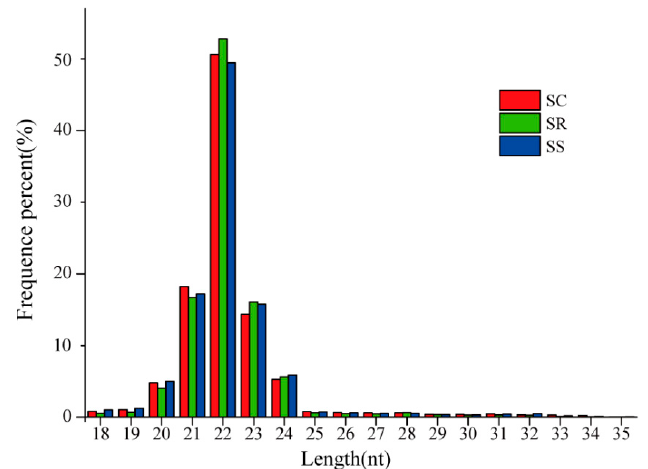
Figure 2. Length distribution of the sequences in SC, SR, and SS libraries.